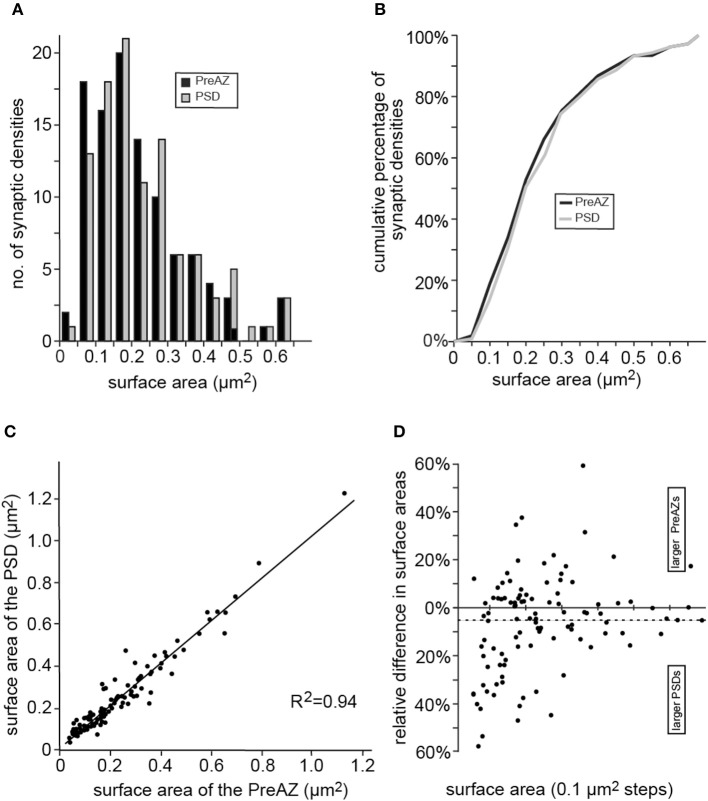
Distribution of the surface areas of PreAZs and PSDs. (A) Bar histogram showing the distribution of surface areas for the PreAZ and PSDs. (B) Corresponding cumulative histogram. Bin width is 0.01 μm2. (C) Correlation histogram between the surface areas of PreAZs and PSDs. Data points are fitted by linear regression. (D) Dot plot showing differences in surface area between PreAZs and PSDs with a skew to larger PSDs. The dashed line indicates the mean.